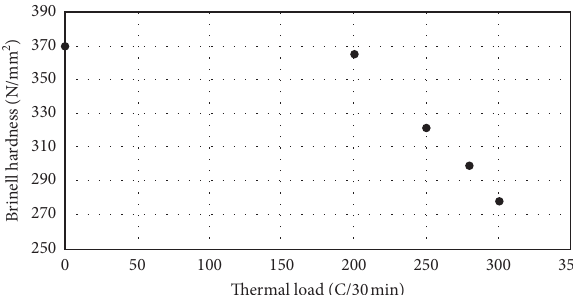
Figure 5: Brinell hardness dependence on thermal loading.